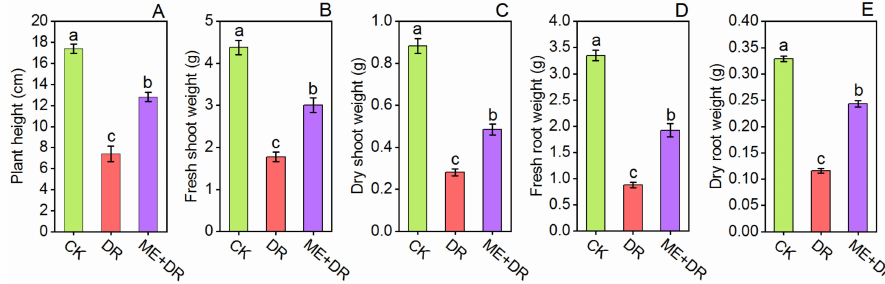
Figure 2. Exogenous supplementation of melatonin promoted the growth [plant height ( A ), fresh shoot weight ( B ), dry shoot weight ( C ), fresh root weight ( D ), and dry root weight ( E )] of tomato seedlings under drought stress conditions. Means ± standard error, n = 3, significant differences are exhibited by lowercase letters ( p ≤ 0.05), according to LSD test.